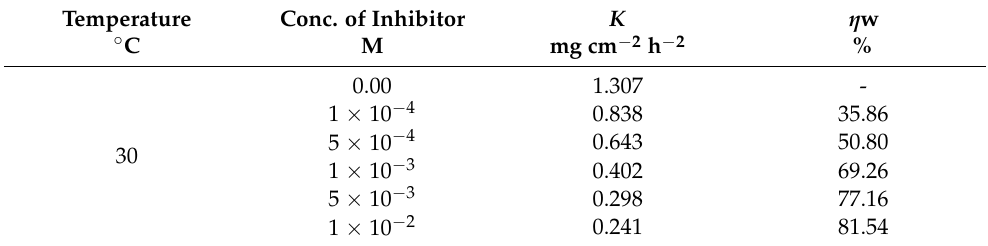
Table 3. Effect of cationic surfactant inhibitor concentration (IIb) at 30 ◦ C temperature degrees. Temperature ◦ C